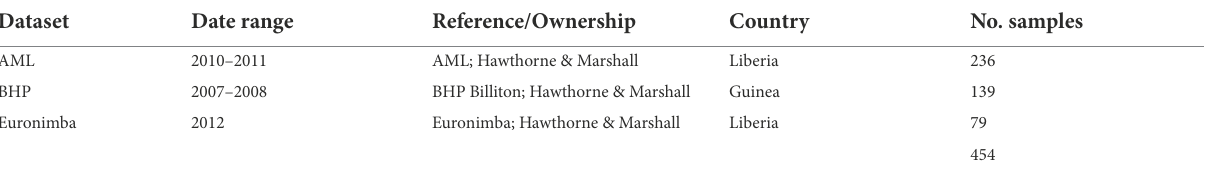
TABLE 2 Datasets compiled for Nimba